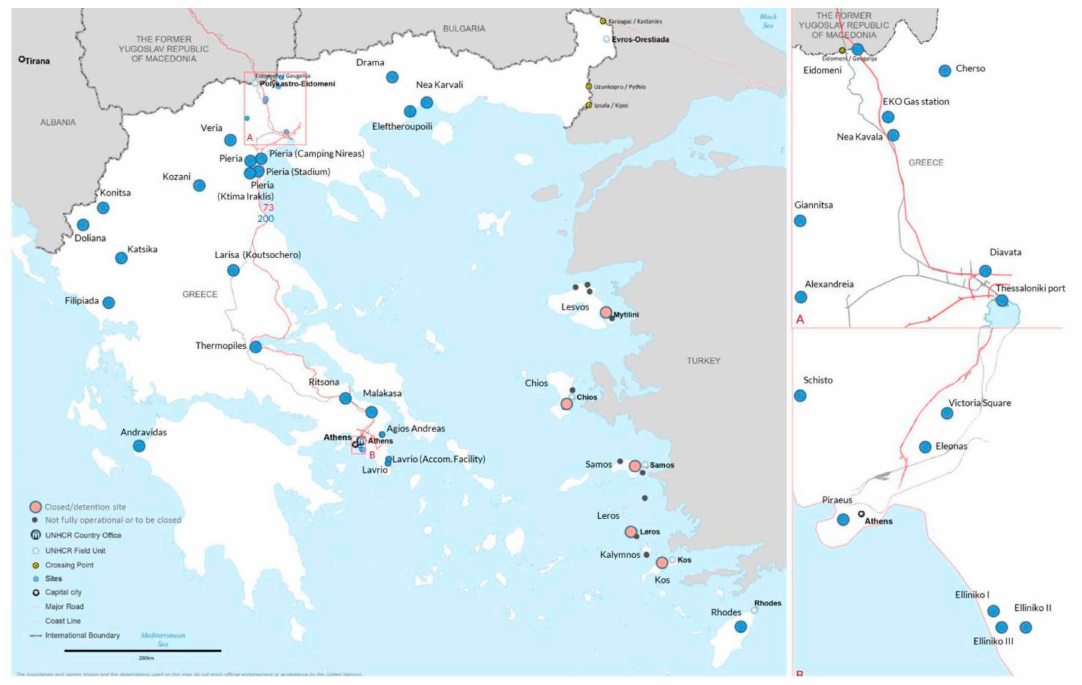
Figure 2. Reception centres in Greece, April